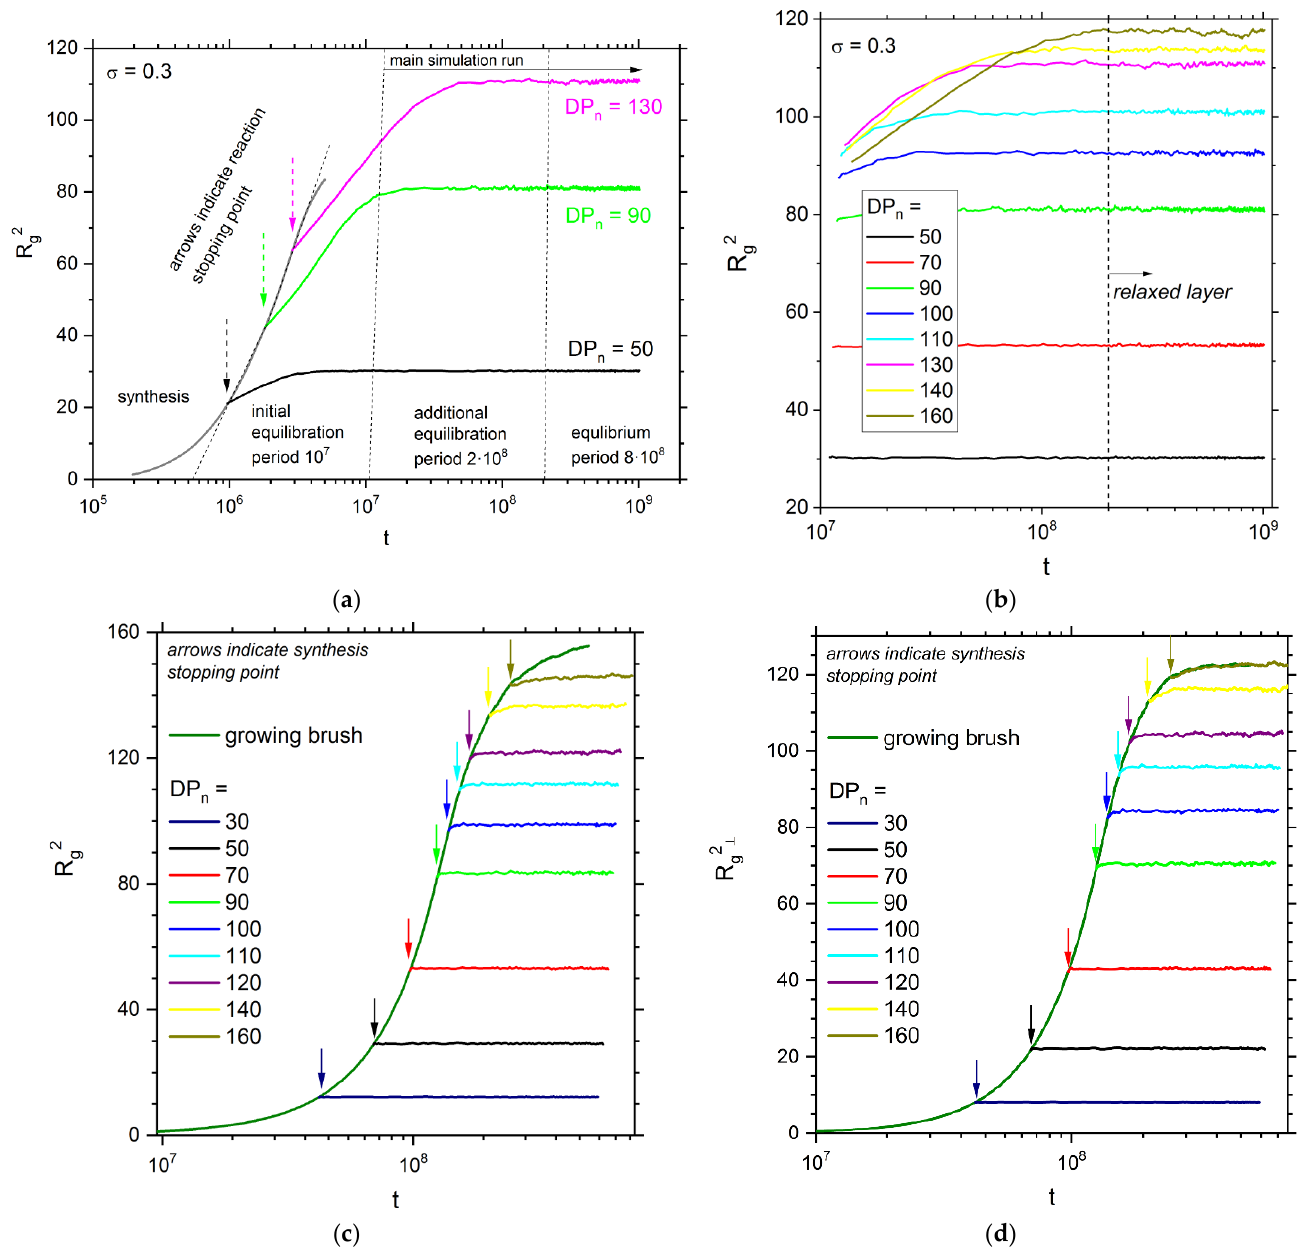
Figure 1. Variation of the mean squared radius of gyration, R g 2 [lattice constants] with the number of Monte Carlo time steps t for: ( a ) three different degrees of polymerization with p = 10 − 4 , ( b ) the equilibration and production run only, ( c ) the production run start marked with arrow in the case of p = 10 − 6 , and ( d ) the changes of the normal component of the mean-squared radius of gyration < R g ⊥ 2 > during the production